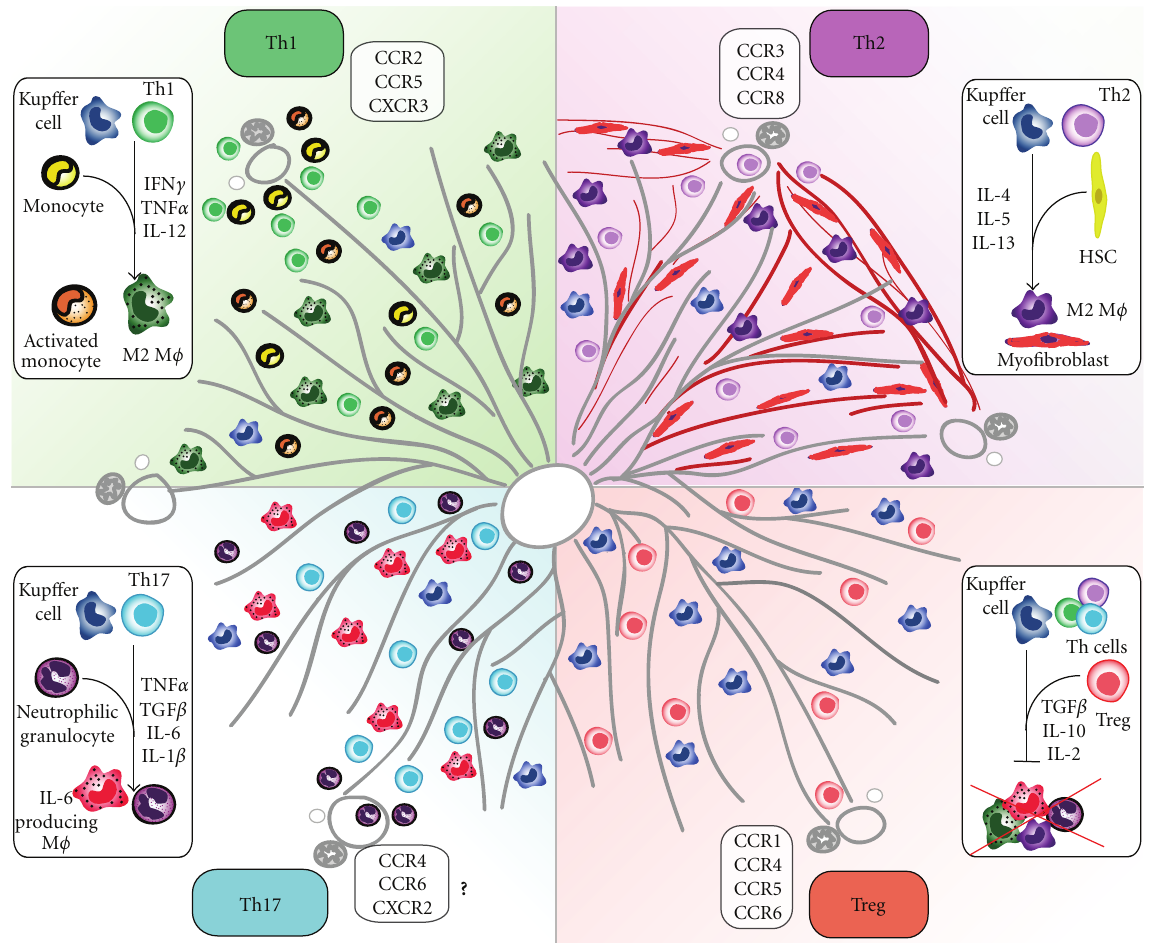
Figure 2: T-cell-mediated inflammation of the liver. Four di ff erent types of T-helper cell responses have been described to influence various inflammatory processes in the liver. Th1 responses lead to classical activation (M1) of liver-resident macrophages such as Kup ff er cells as well as recruitment of monocytes from the bloodstream, promoting a proinflammatory environment by secretion of IFN γ , TNF α , and IL-12. Th1 infiltration is mediated mainly by engagement of chemokine receptors CXCR3 and CCR5. Th2-type responses are thought to lead to an alternative activation of macrophages (M2) via IL-4 and IL-13, leading to a profibrotic response by activation of hepatic stellate cells (HSC) and inducing their di ff erentiation into myofibroblasts. Th2-type responses are linked mainly to CCR3- and CCR4- mediated chemokine signalling as well as potentially CCR8 under certain conditions. Th17 cell responses in the liver have only recently been described to be involved in various inflammatory processes induced, for example, by alcohol-induced liver disease, HCC, or HBV/HCV-induced hepatitis. Th17 cells lead to activation of macrophages and recruitment of neutrophils, inducing an innate response by secretion of cytokines such as IL-1 β , IL-6, and TNF α but also regulatory factors such as TGF β . Recruitment of Th17 cells may be associated with CCR6- and possibly also CCR4-mediated signalling. T regulatory cells (Treg) have been described to be mainly immunosuppressive, secreting anti-inflammatory cytokines such as IL-10 and TGF β as well as consuming IL-2, which is a key factor for immunogenic activation of T cells. Therefore, Treg inhibit and suppress T-cell activation and e ff ector functions as well as preventing activation of innate immune cells. A broad variety of chemokine receptors have been linked to Treg migration, for example, CCR1 and CCR4 but also CCR5 as well as CCR6, suggesting a functional overlap for these receptors in di ff erent T-helper cell